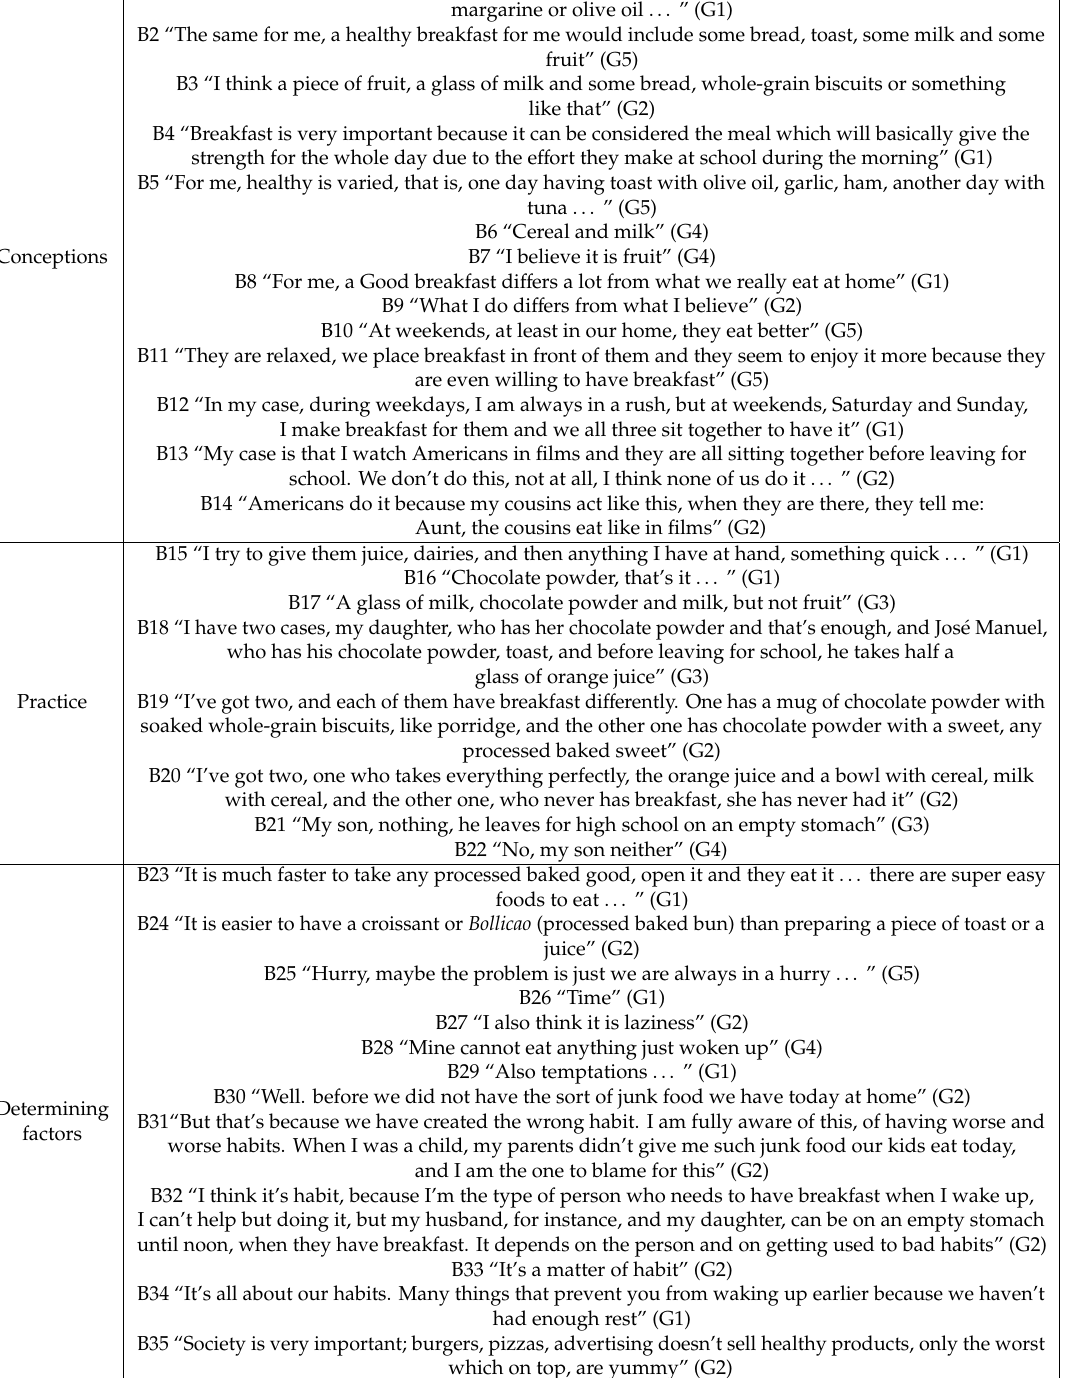
Table 3. “Healthy Breakfast” study